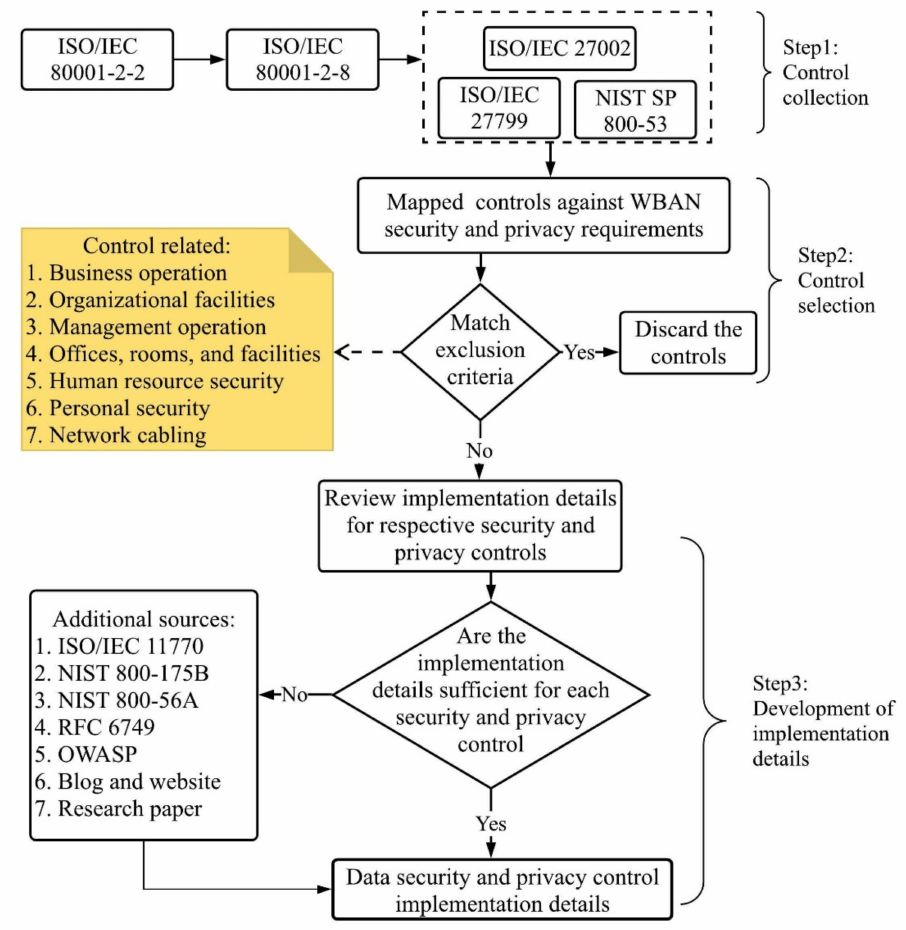
Figure 3. Data security and privacy control guidelines development